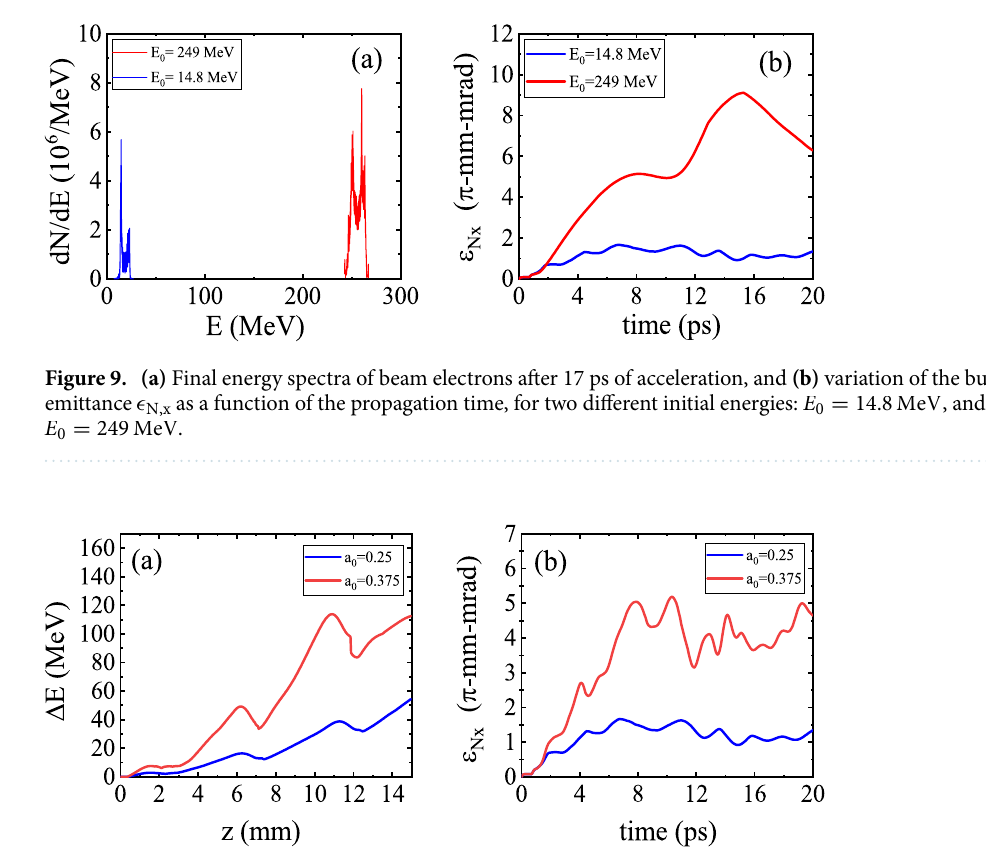
0.25 and a 0 0.375 . In both = =